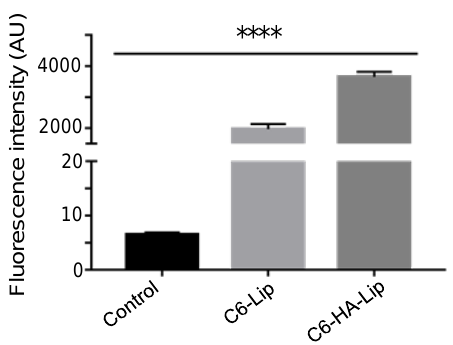
Figure 7. Mean fluorescence intensity of B16F10 cells following treatment with C6-Lip and C6-HA- Lip. (Comparison between groups, **** p < 0.0001; n = 3).